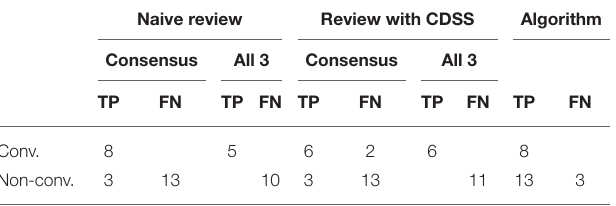
TABLE 4 | Percent of overlap between known seizures and true positive events marked by reviewers and the automated algorithm.